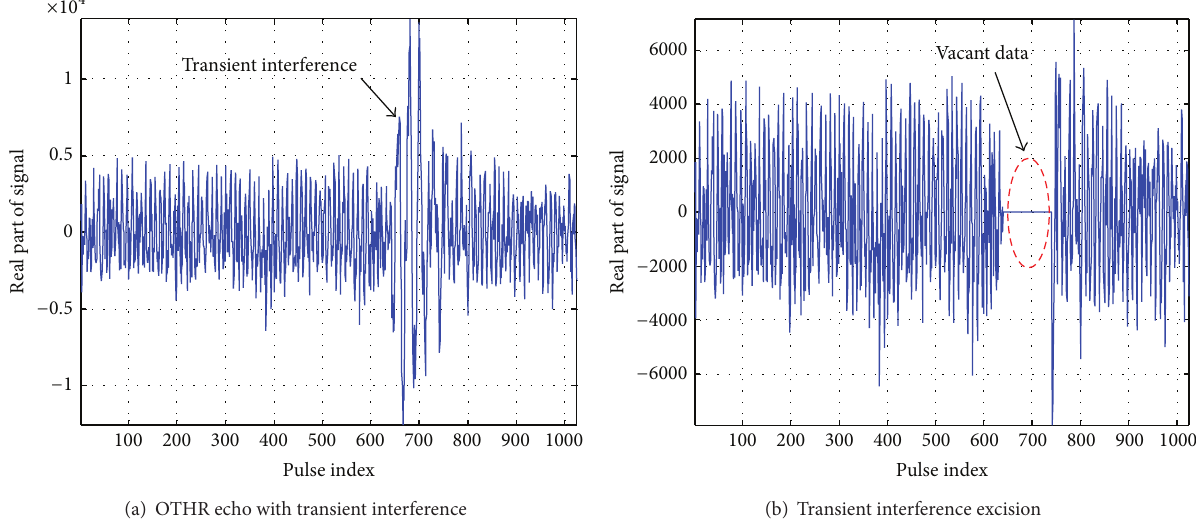
Figure 1: Transient interference excision induces signal